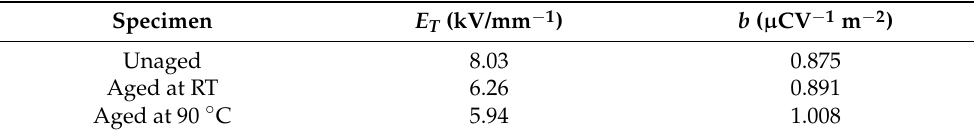
Figure 13. Relation between mean magnitude of space charge density and applied electric field of water aged samples [30]. Table 3. Space charge parameter values of unaged and water aged samples